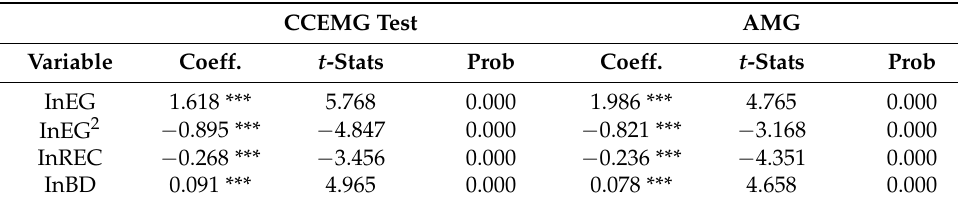
Table 7. The outcomes of CCEMG and AMG.